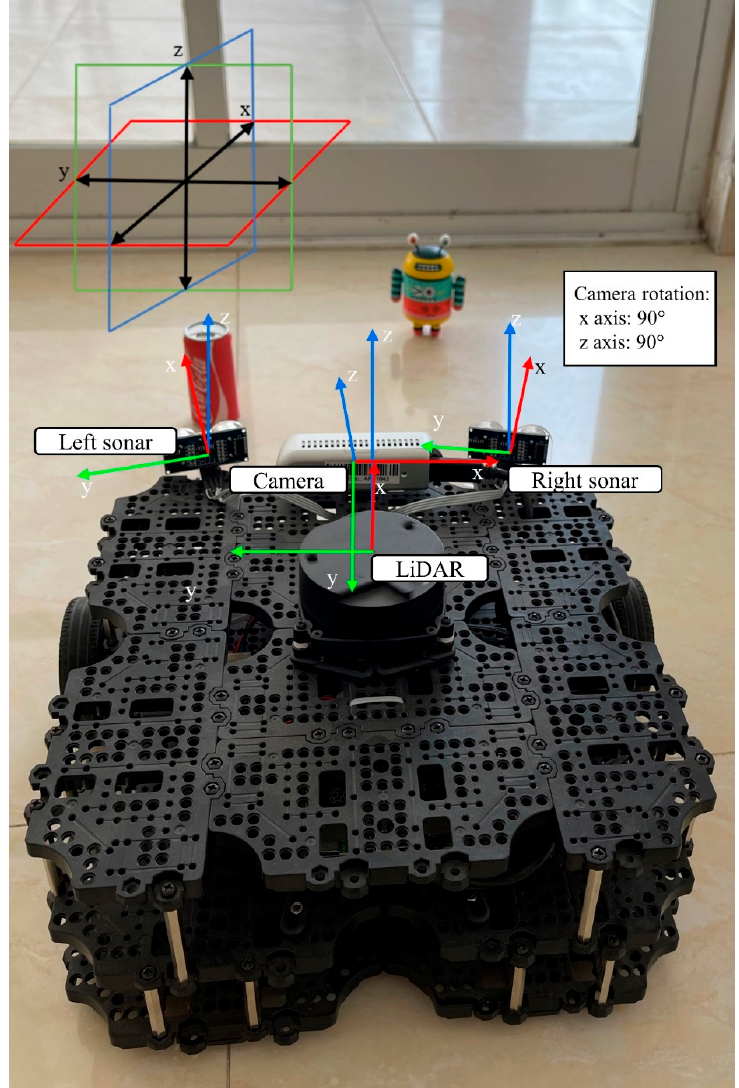
Figure 8. Sensors’ reference frames with obstacle in proving ground.